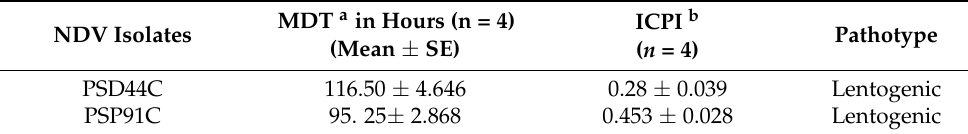
Table 1. Pathogenicity assessment of chicken-adapted Newcastle disease virus (NDV) isolates PSD44C and